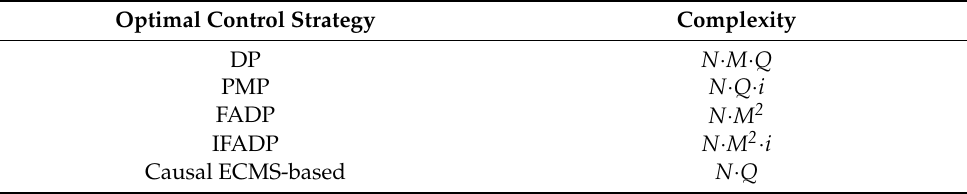
Table 3. Complexity of each considered optimal supervisory control strategy.